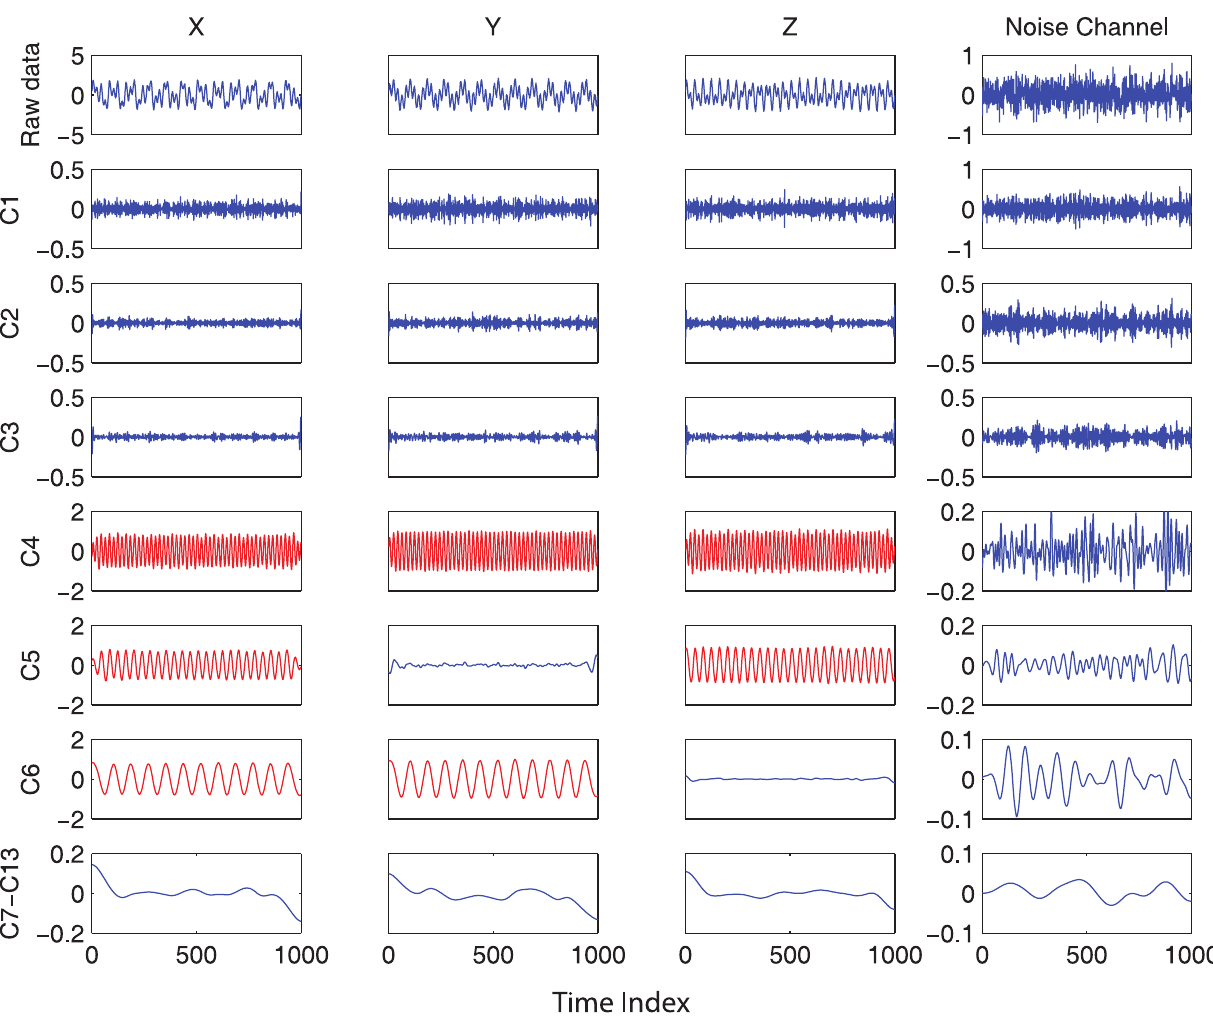
Figure 1. MEMD decomposition of composite time series consisting of the original 3-channel synthetic data [X Y Z] and noise reference channels. For the purpose of clarity, only one noise channel is shown. All the sine waves with distinct frequencies (red) are correctly obtained via MEMD. At the same time, the IMFs obtained from the added noise channel provide the reference for statistical identification of significant IMFs.